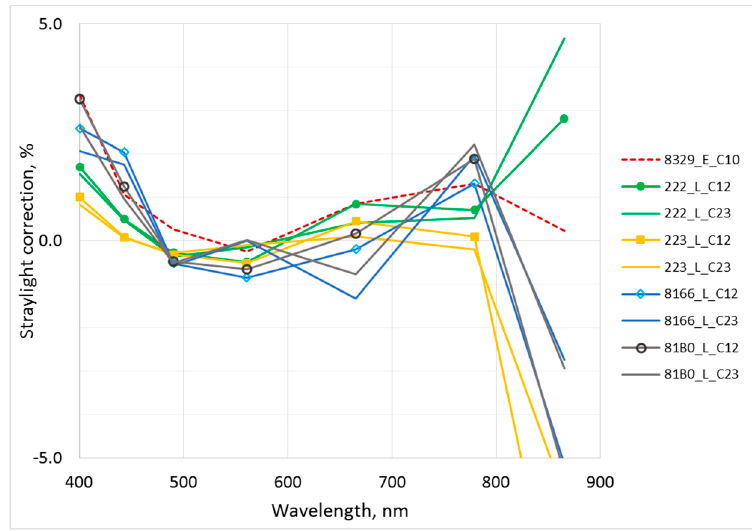
Figure 17. Stray light effects in the outdoor experiment. One RAMSES 8329 irradiance sensor—dashed line; two RAMSES and two HyperOCR radiance sensors: Solid lines with markers—blue sky (C12), and solid lines without markers—sunlit water (C23).